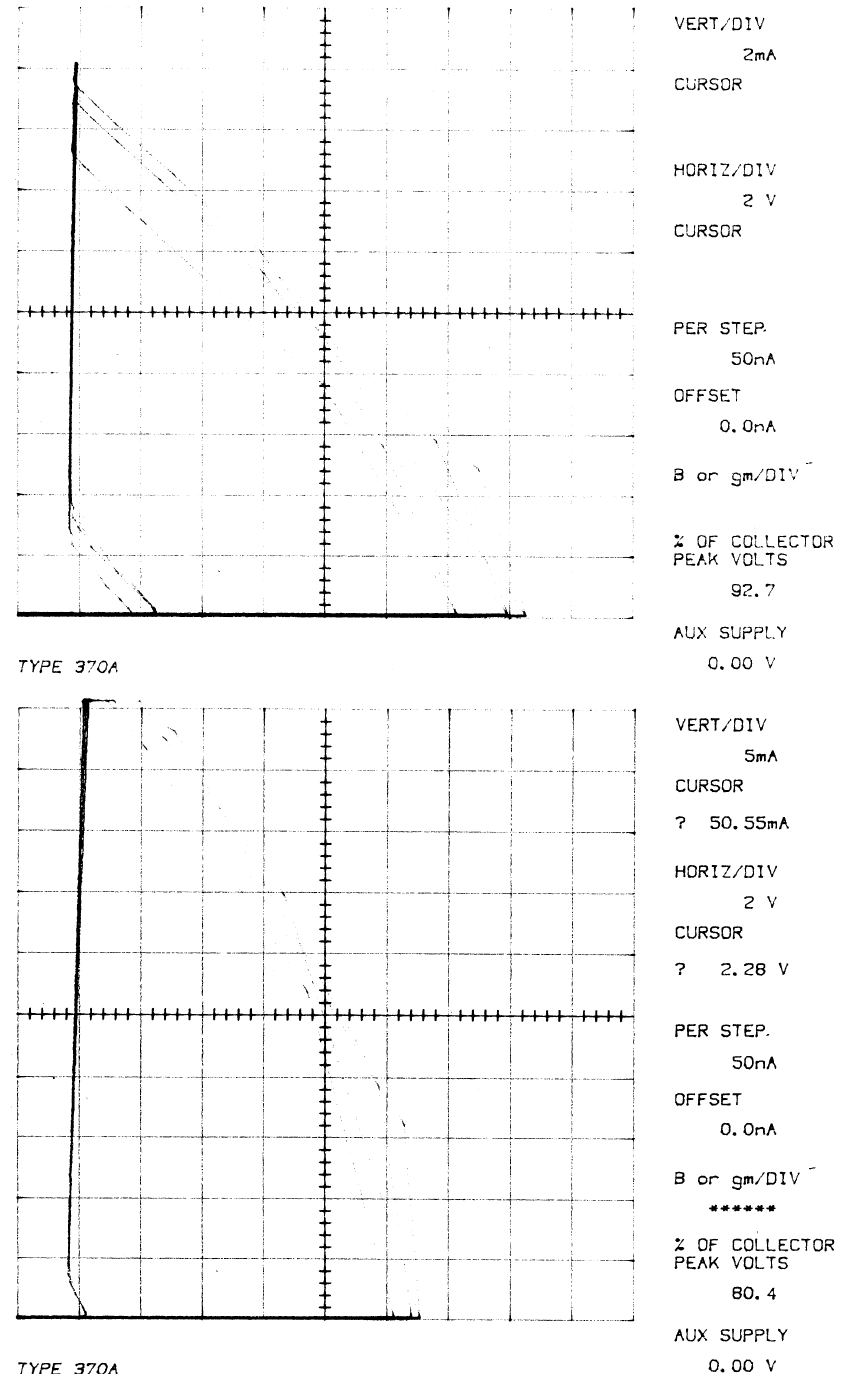
FIGURE 2 The typical I – V characteristics of the GaAs MISS with different epitaxial doping concentrations of (a) N A ¼ 5 (cid:3) 10 16 cm (cid:4) 3 (b) N A ¼ 8 (cid:3) 10 16 cm (cid:4) 3